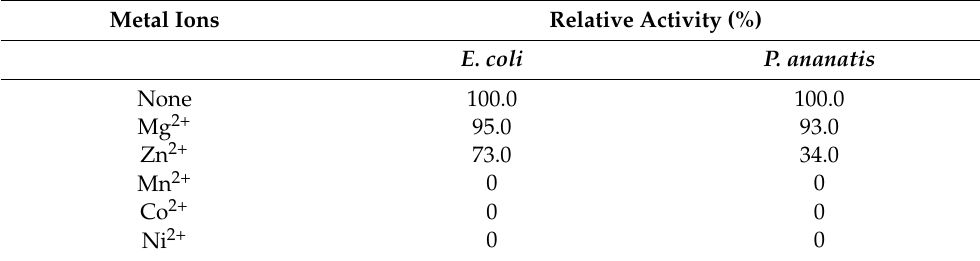
Table 3. Effect of metal ions on the activity of D2HGDH Ec and D2HGDH Pa